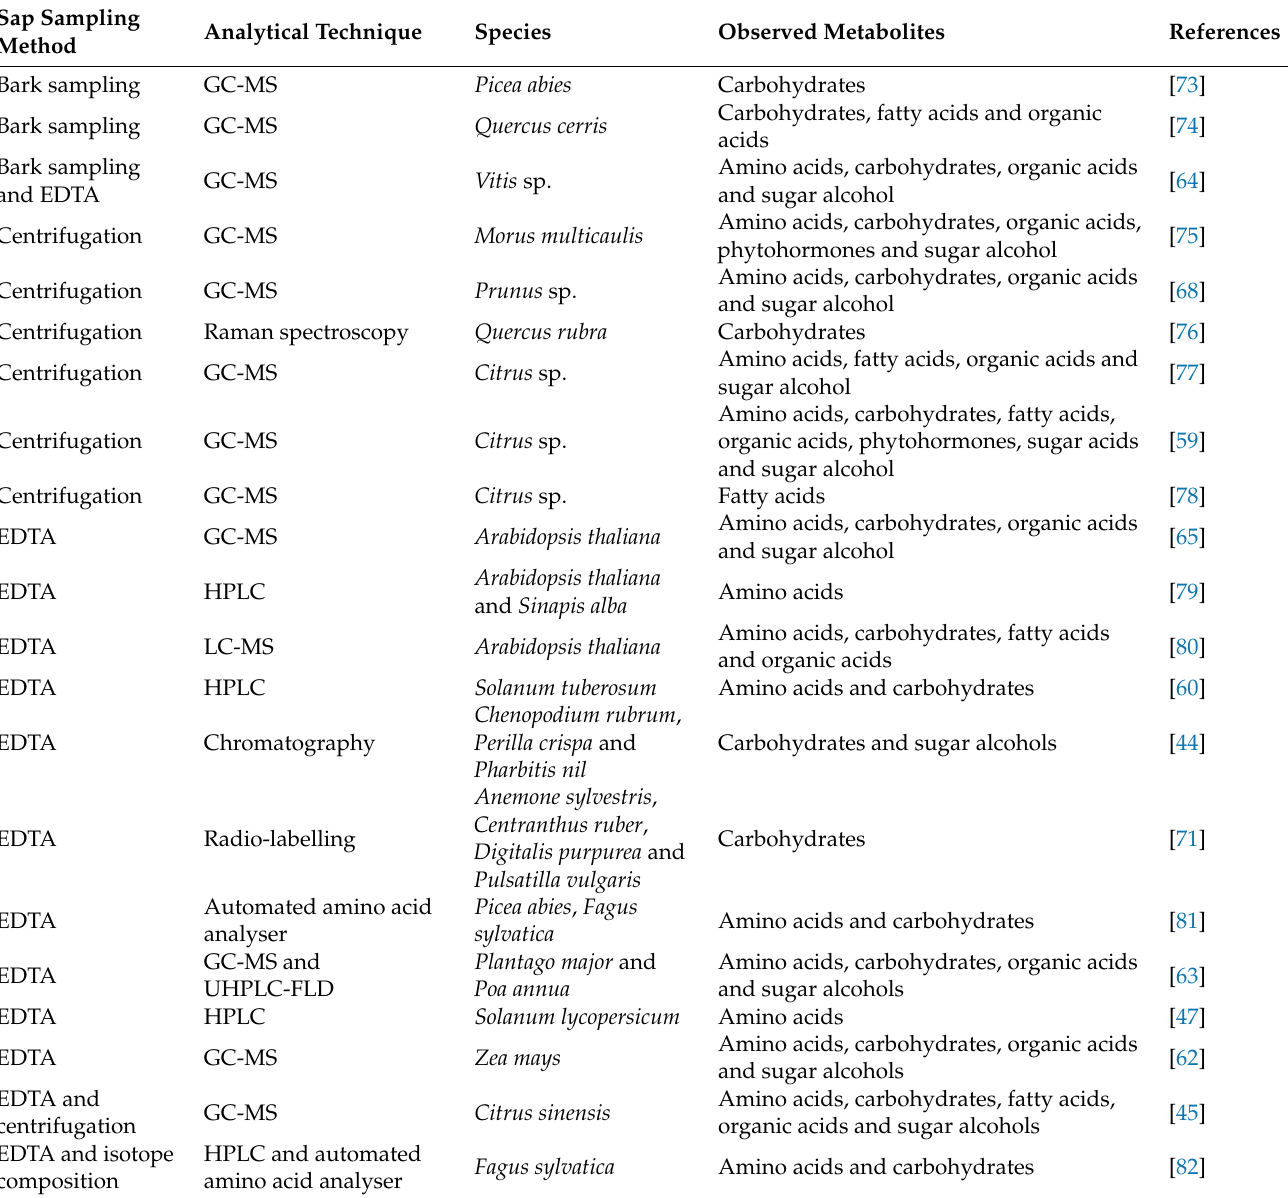
Table 1. Literature survey of papers where phloem sap metabolic analyses have been carried out (classified by sap sampling